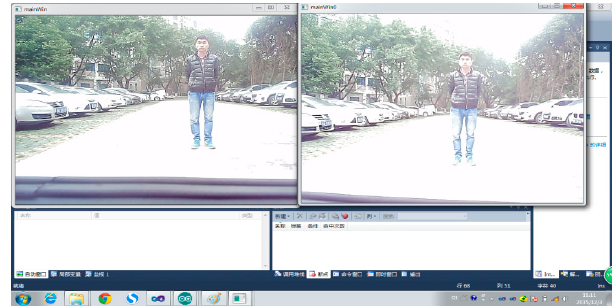
Figure 4. Installation board of multi-sensors.